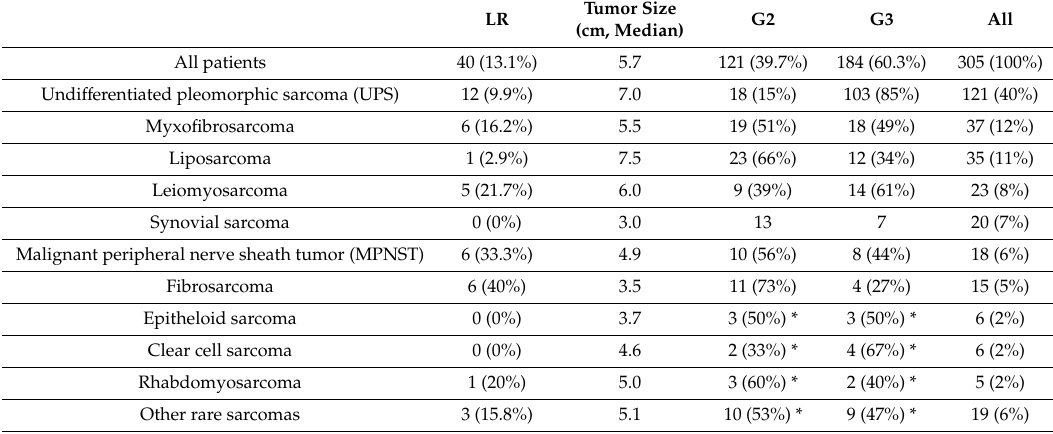
Table 1. Comparison of local recurrence, tumor size, and grading by histology in 305 patients with soft tissue